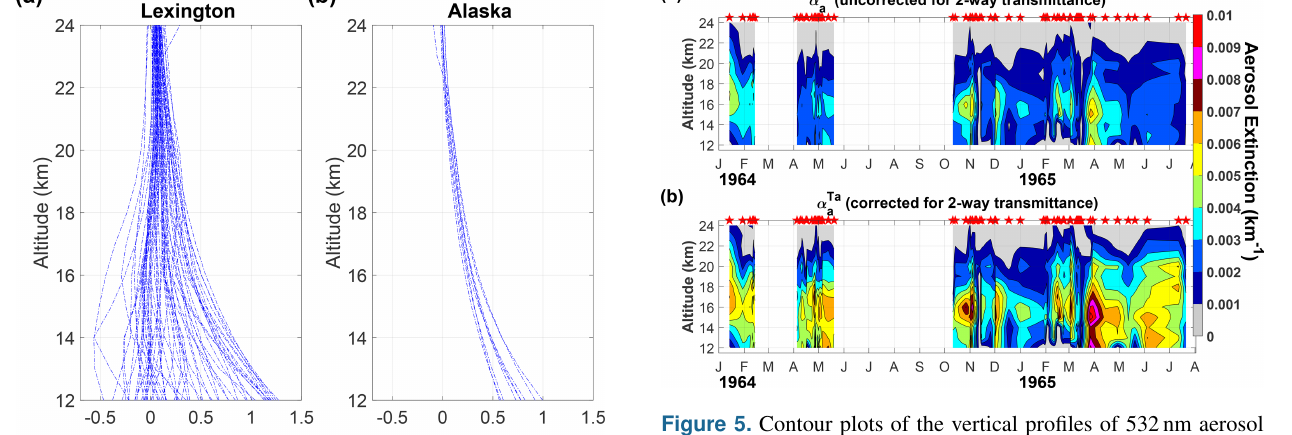
Figure 5. Contour plots of the vertical profiles of 532nm aerosol extinction α a (532 ,z ) ∗ at Lexington, showing values uncorrected and corrected for two-way transmittance, α T a a (532 ,z ). The red stars indicate the dates on which the measurements were